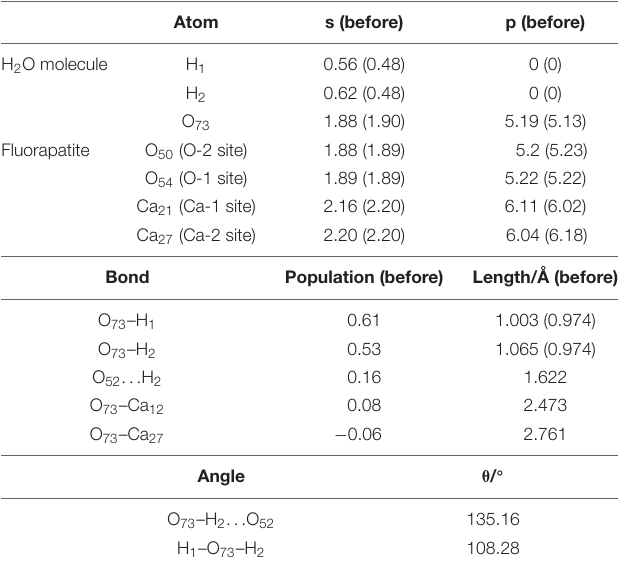
TABLE 3 | Charge transfer and bond properties of the three-site